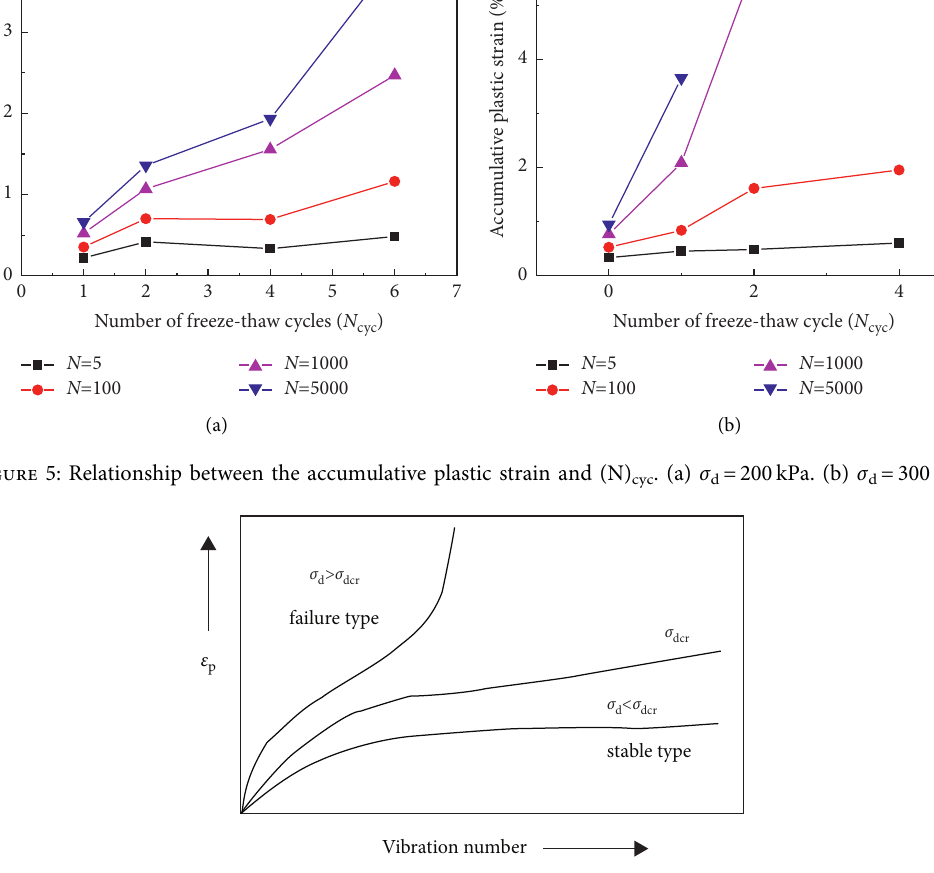
Figure 6: Schematic diagram of accumulative plastic strain development